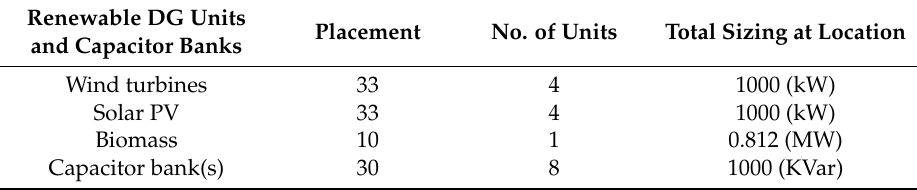
Table 7. The optimal placement and sizing of renewable DG units and capacitor banks in the distribution system.